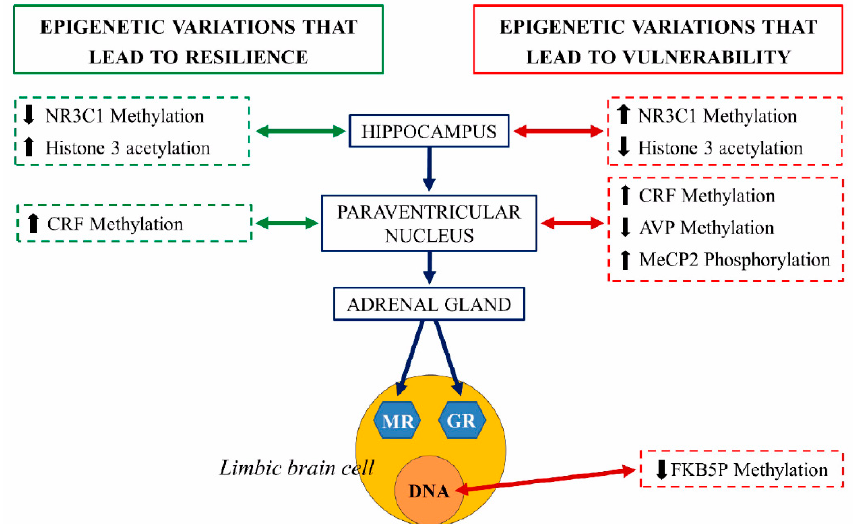
Figure 8. Schematic representation of the epigenetic regulation of the hypothalamus-hypophysis- adrenal axis (grey axis). The right side of the figure illustrates the epigenetic changes that lead to vulnerability to stress and risk at each structure (red arrow). The left side represents epigenetic variations that lead to resilience at each structure (green arrow). NR3C1: steroid receptor gene, pMeCP2: phosphorylated protein related to methylation of histones, CRF, corticotropin-releasing factor gene, AVP: arginine vasopressin gene, FKBP5: gene coding for chaperones for the expression of glucocorticoid receptors (GR) and mineralocorticoid receptors (MR) [104].